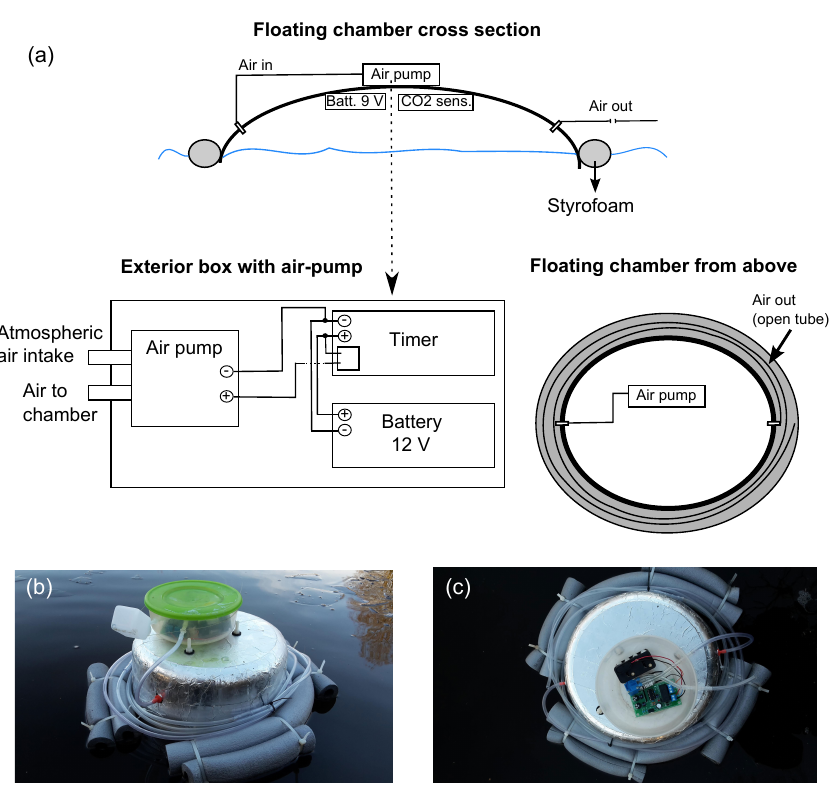
Figure 1. (a) Schematic drawing of the floating chamber with automatic ventilation showing the box, which contains an air pump, a timer and a battery (upper part); cross section (lower left) and view from above (lower right) of the entire floating chamber, (b) picture showing the floating chamber deployed on a lake, and (b) floating chamber viewed from above showing the exterior box containing the air pump and timer.